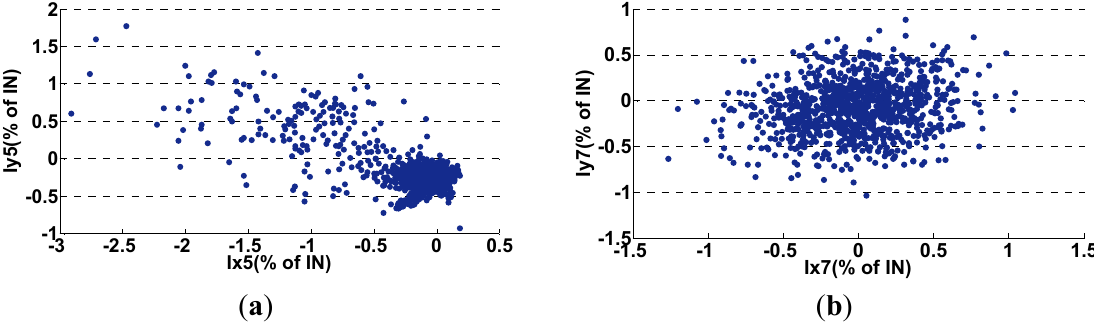
Figure 11. Scatter plots of wind farm harmonic current X - Y projections. ( a ) The fifth harmonic currents; ( b ) The seventh harmonic